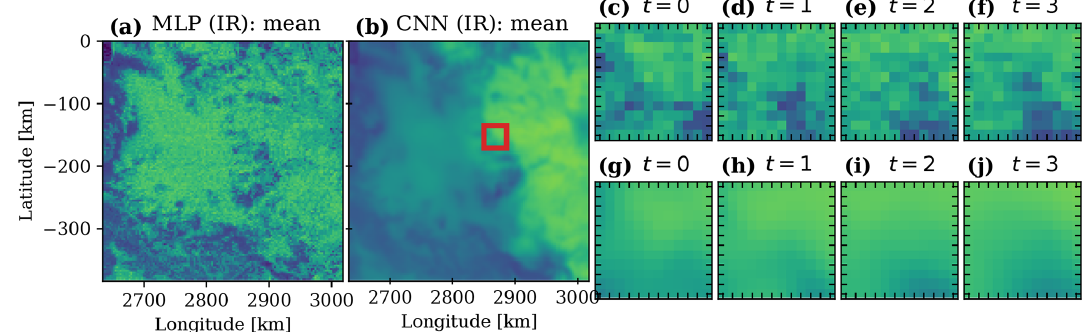
Figure 13. (a, b) One frame from the visual animations showing IWP retrievals from the IR input setting corresponding to the first observation of 2012 (nighttime) over the land area. MLP retrievals in panel (a) , where the mean is used as a point estimate, and analogously for CNN retrievals in panel (b) . Panels (c–f) show the retrieval at t observations from the retrieval in panel (a) , zoomed into the area shown in red in panel (b) ; analogously for panels (g–j) for panel (b) . Same colour scale as in Fig.